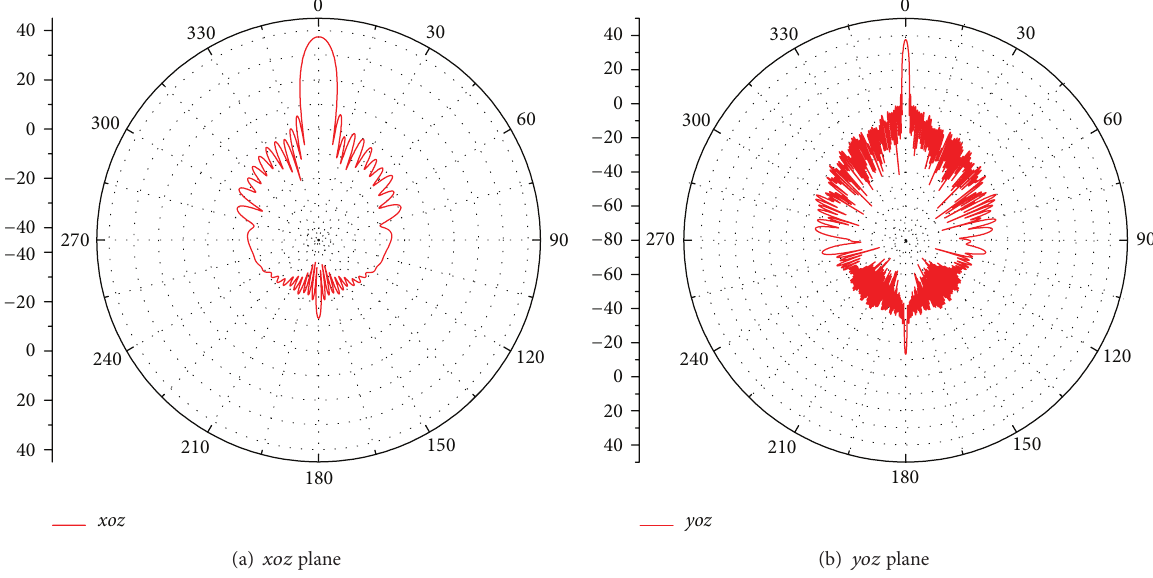
Figure 10: The radiation patterns of the ellipse microstrip antenna array.